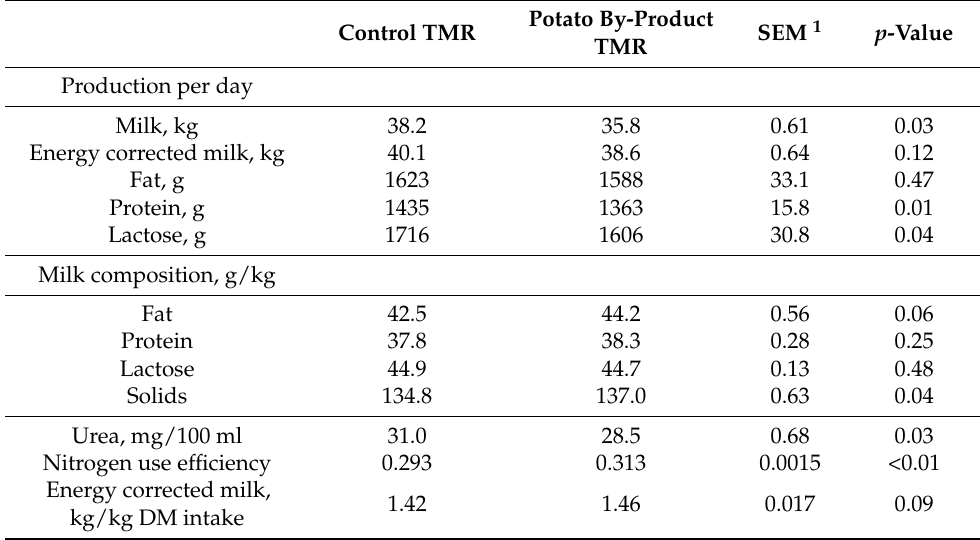
Table 6. Milk production, composition and efficiency of milk production of the dairy cows fed different total mixed rations (TMR; Experiment 1). Potato Control TMR